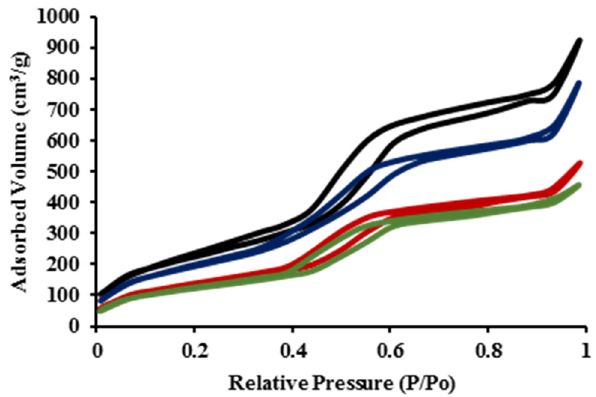
Figure 1. Nitrogen sorption isotherms of MSNs ( black ), AlClPc-MSNs ( blue ), cisplatin-MSNs ( red ), and AlClPc/cisplatin-MSNs ( green ).